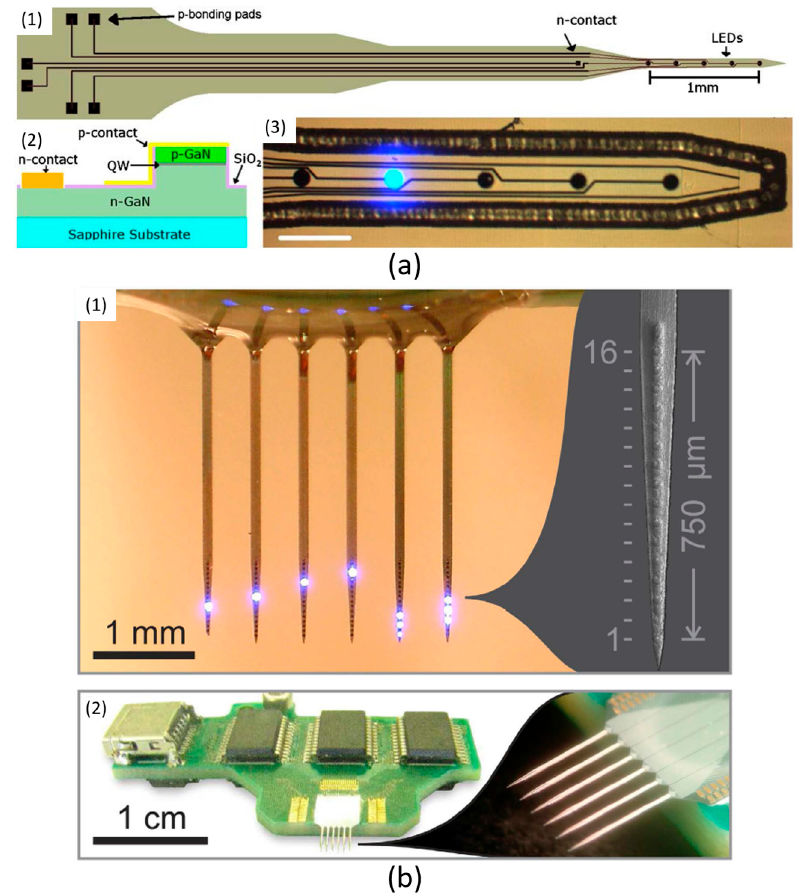
Figure 4. ( a ) Sapphire-based GaN µLED optrode in [50]. (1) System architecture of this optrode. Six bonding pads are placed at the head part to control corresponding µLEDs which are uniformly positioned along the optrode shaft. (2) The cross-section view of the fabrication process. (3) The optrode shaft including five µLEDs, one of them turned on with bright light. This figure is reprinted with permission from ref. [50]. ( b ) Silicon-based 6-shank GaN µLED optrode in [51]. (1) 16 stimulation sites are created on each shank, and they are uniformly distributed along the 750 µm shaft. Every µLED can be individually manipulated. (2) System diagram. The fabricated optrode is bonded on a dedicated control PCB. This figure is reprinted with permission from ref. [51].